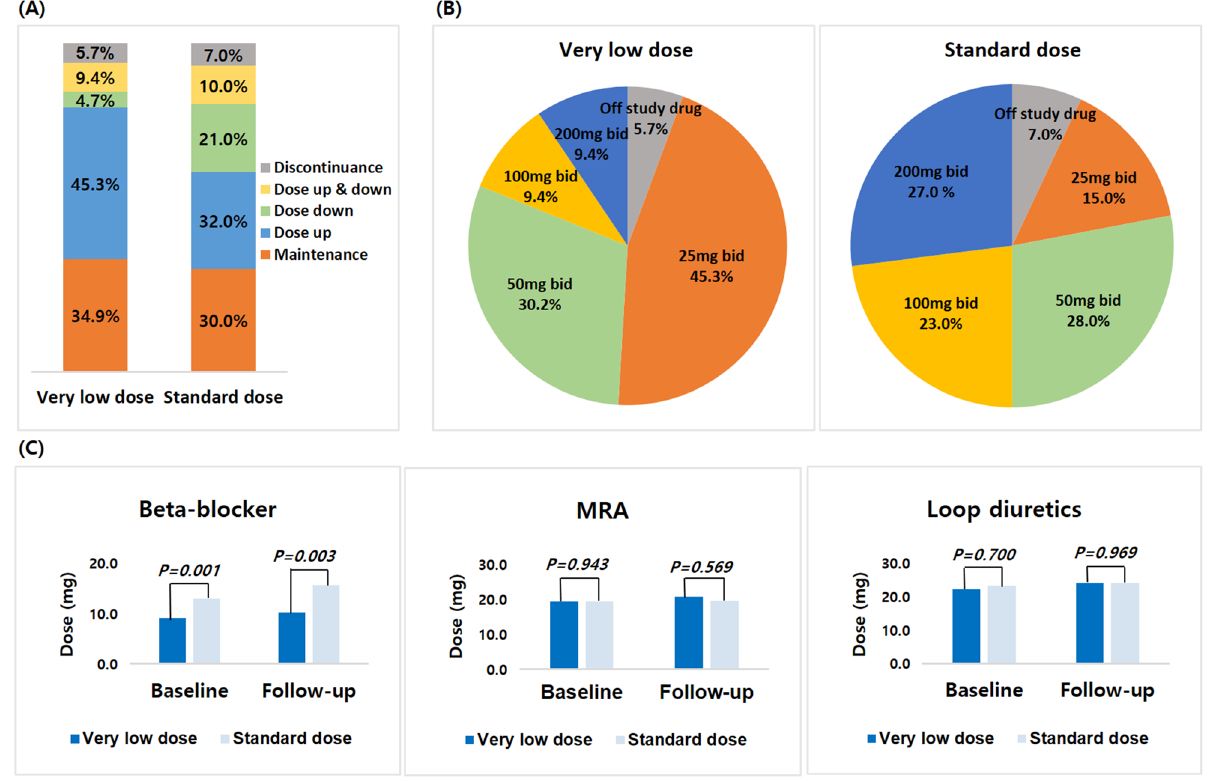
Figure 2. Heart failure guideline-directed medical therapies at follow-up compared with baseline for very low-dose and standard dose of sacubitril/valsartan groups. Panel ( A ) Pattern of dose titration, comparing very low-dose and standard dose sacubitril/valsartan groups (panel A ). Pane ( B ) Proportions of patients achieving different sacubitril/valsartan dose levels in the very low-dose and standard dose sacubitril/valsartan groups (panel B ). Panel C: Dosing of other heart failure treatments in the very low-dose and standard dose sacubitril/ valsartan groups. The p -value represents a comparison between very low-dose and standard dose of sacubitril/ valsartan at baseline and follow-up.